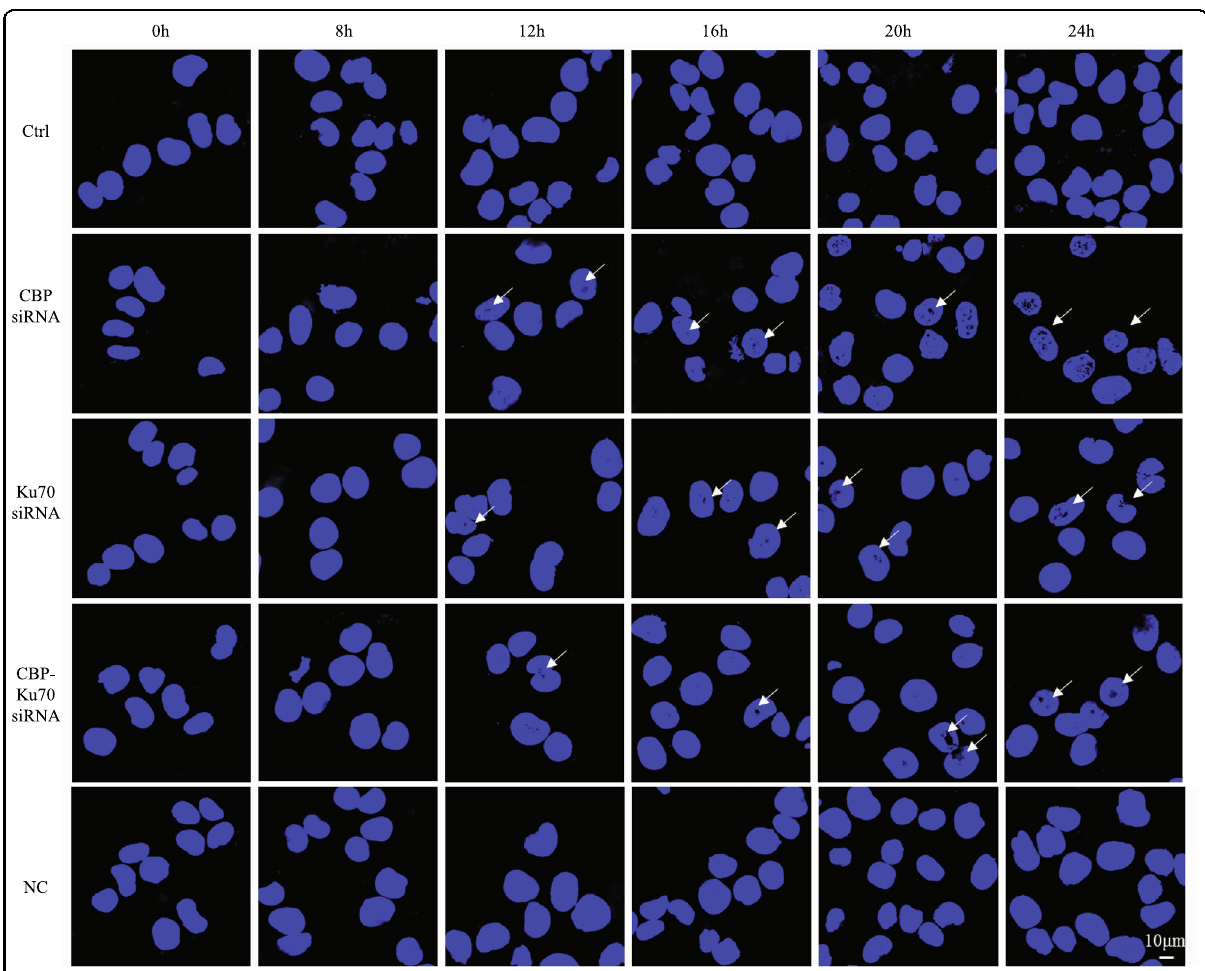
Fig. 5 Depletion of CBP and/or Ku70 caused chromatin condensations in human melanoma A375 cells. Nuclear morphology under confocal fl uorescence microscopy (×1000). Chromatin condensation appeared 16 h after CBP siRNA transfection (white arrow). Experimental grouping: CBP siRNA (70% depletion) group, Ku70 siRNA (70% depletion) group, and CBP-Ku70 co-transfection of siRNA (60% depletion for CBP and Ku70, respectively)